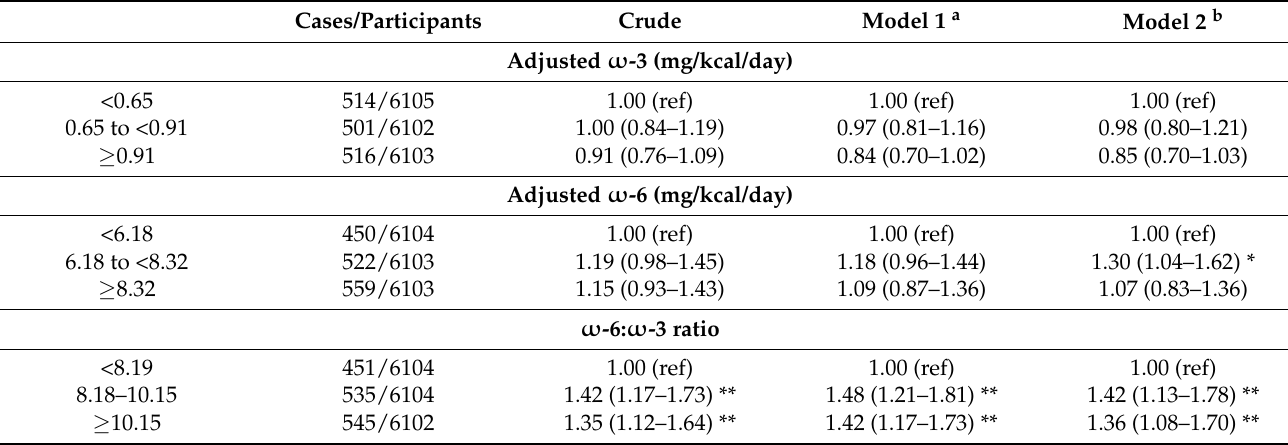
Table 2. Weighted odds ratios (95% confidence intervals) of sleep disorders across tertile of energy-adjusted dietary ω -3 and ω -6 fatty acid intake and ω -6: ω -3 ratio, NHANES 2007–2014.